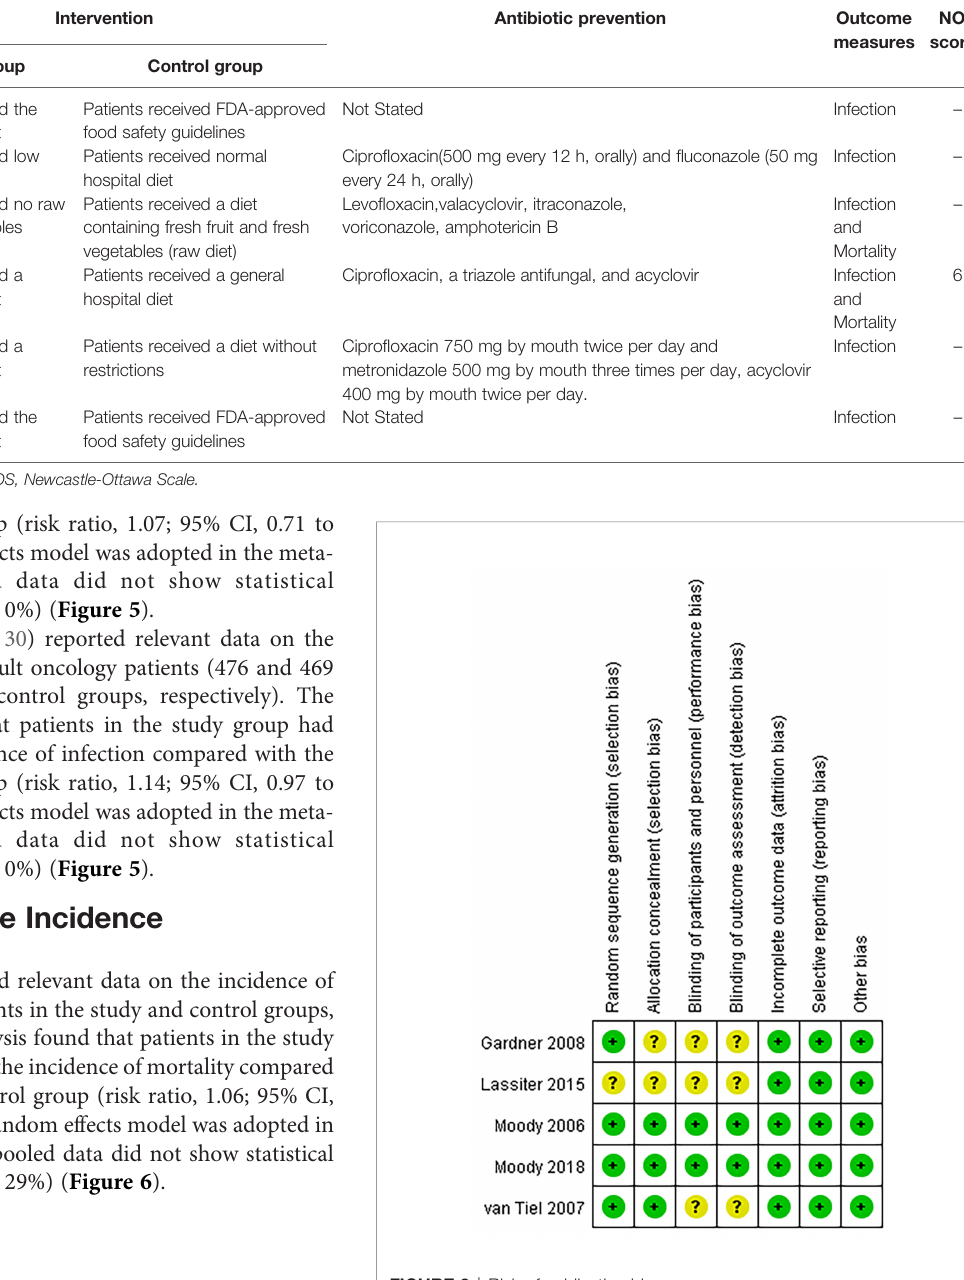
FIGURE 2 | Risk of publication bias